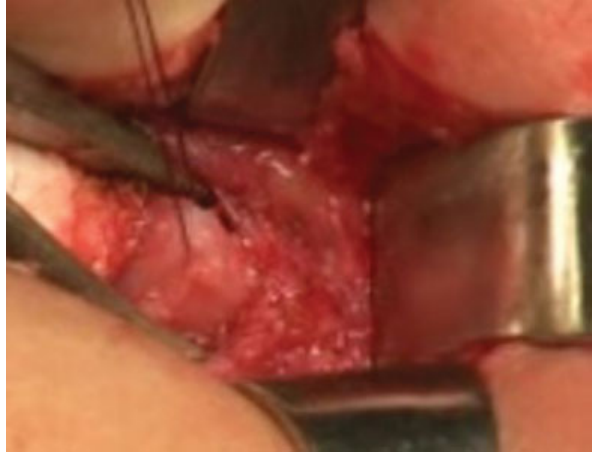
Fig. 1 The lower part of the muscle complex was retracted down to expose the posterior wall of the rectum.